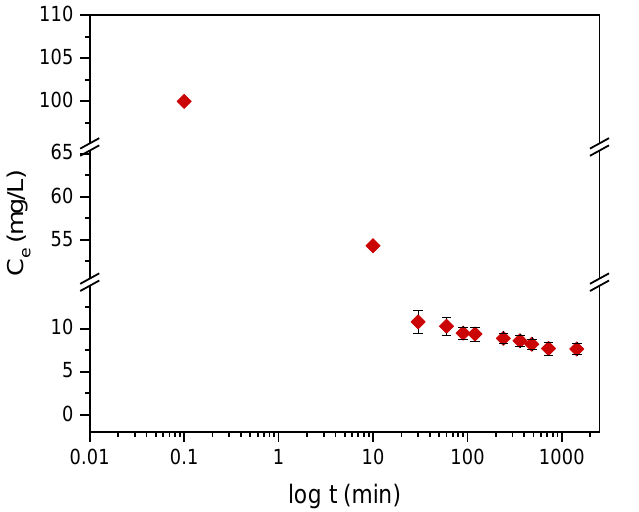
Figure 10. The dependence of the residual concentration of DO on the contact time with the plasma-treated LDPE powder.